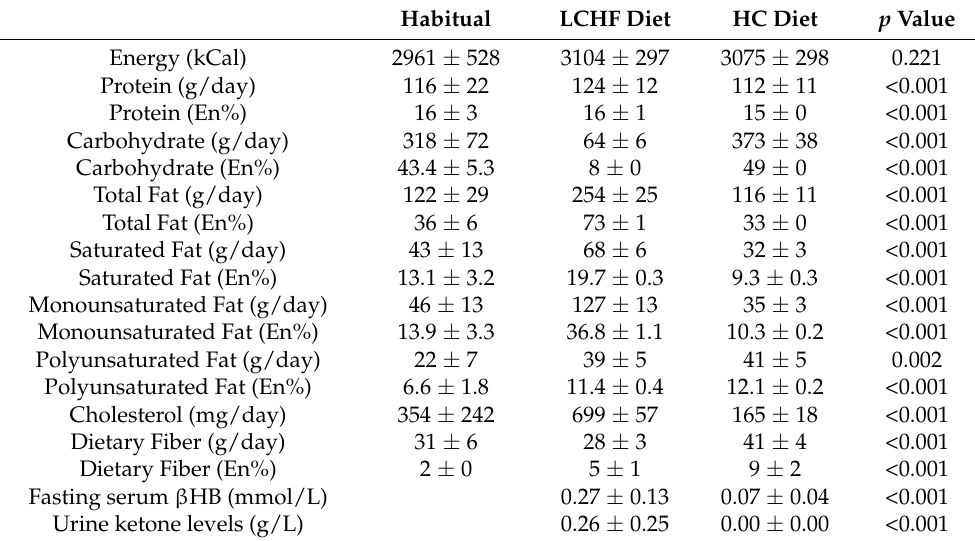
Table 2. Dietary intake and fasting serum and urine ketone